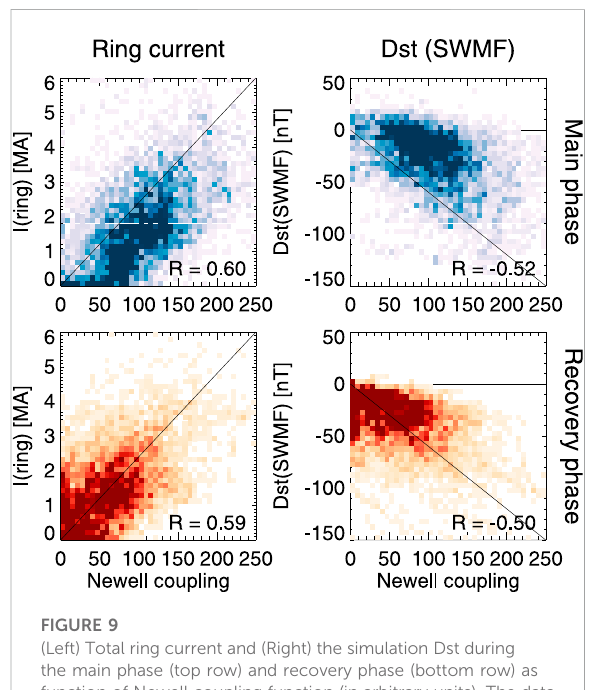
FIGURE 9 (Left) Total ring current and (Right) the simulation Dst during the main phase (top row) and recovery phase (bottom row) as function of Newell coupling function (in arbitrary units). The data are snapshots taken at 15-min cadence in the magnetotail, tagged with the 30-min smoothed values of the driver intensity. The heat maps indicate the share ofpoints falling in each bin.